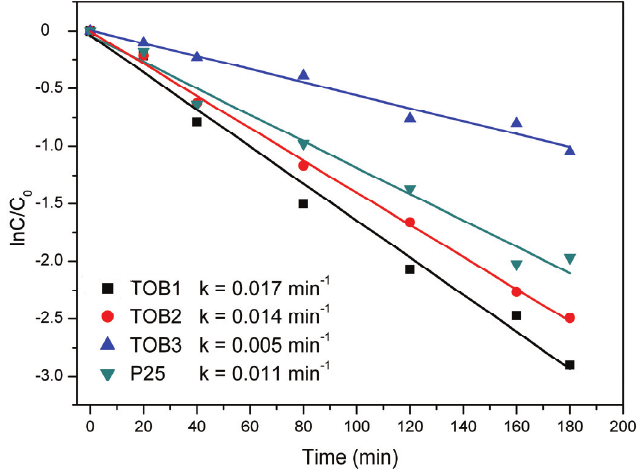
Figure 6. Pseudo-first-order kinetic plots for the photodegradation of RhB, where k is the apparent first-order rate